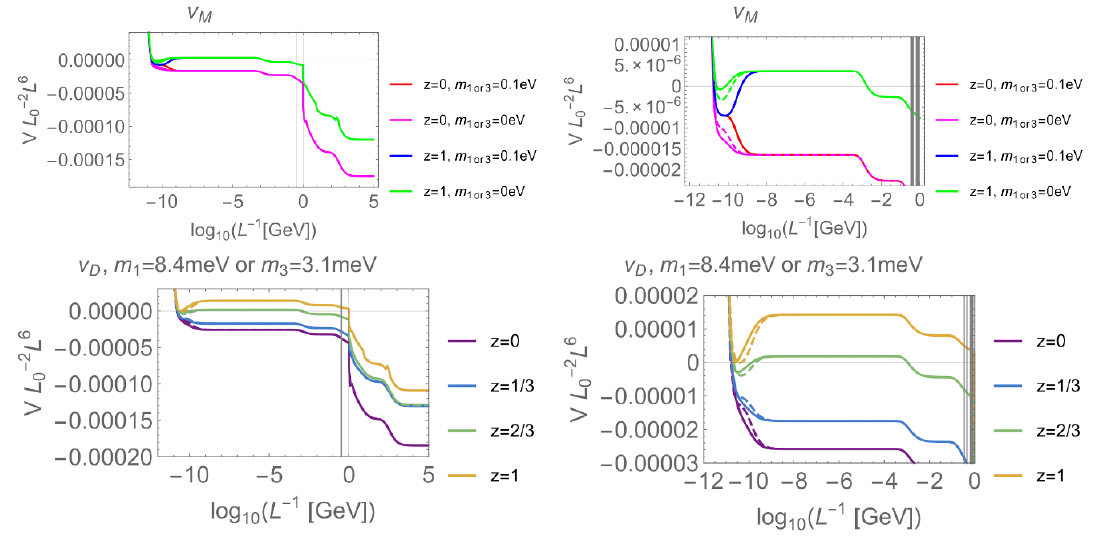
Figure 4 . S 1 compacti(cid:12)cation of the SM. The e(cid:11)ective potential as a function of the radion L . Here the Wilson lines are (cid:12)xed at the potential minimum. \ (cid:23) " represents Majorana (Dirac) M ( D ) neutrino, and z is the boundary condition of fermion ! (cid:0) e (cid:0) i(cid:25)z . The shaded region is close to the QCD scale, 0 : 3{1 GeV, around which perturbation theory is not good. Right (cid:12)gures are enlarged view of the left (cid:12)gures. The solid and dashed line correspond to the normal and inverted hierarchy, respectively. We can see that there is vacuum at around the neutrino mass scale if the boundary condition is close to the periodic one.